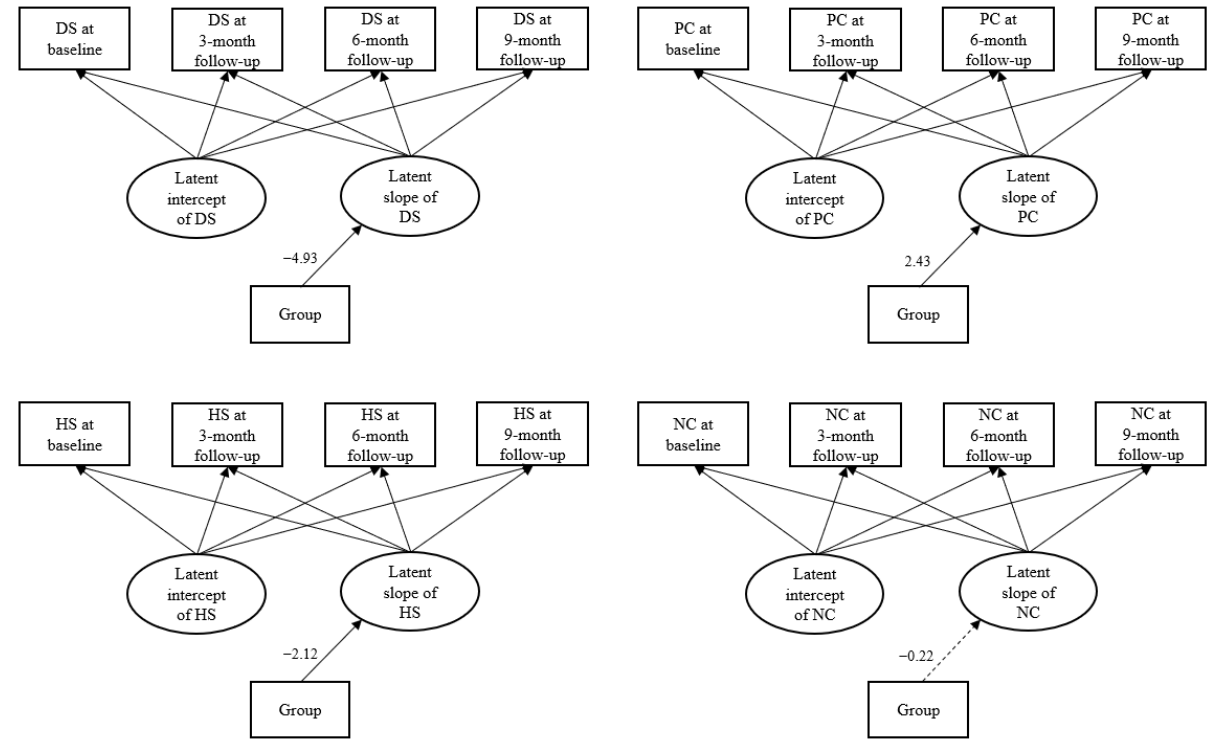
Figure 2. Conditional latent growth curve modeling examining the effects of the mobile health intervention on the outcome and potential mediators. Continuous lines with arrows indicate statistically significant paths. Dotted lines indicate nonsignificant paths. The first and second factor loadings of the latent slope of all models were set to 1, the third and fourth factor loadings of the latent slope of all models were freely estimated. Group: intervention or control group; DS: depressive symptoms; HS: HIV-related stigma; PC: positive coping; NC: negative coping.